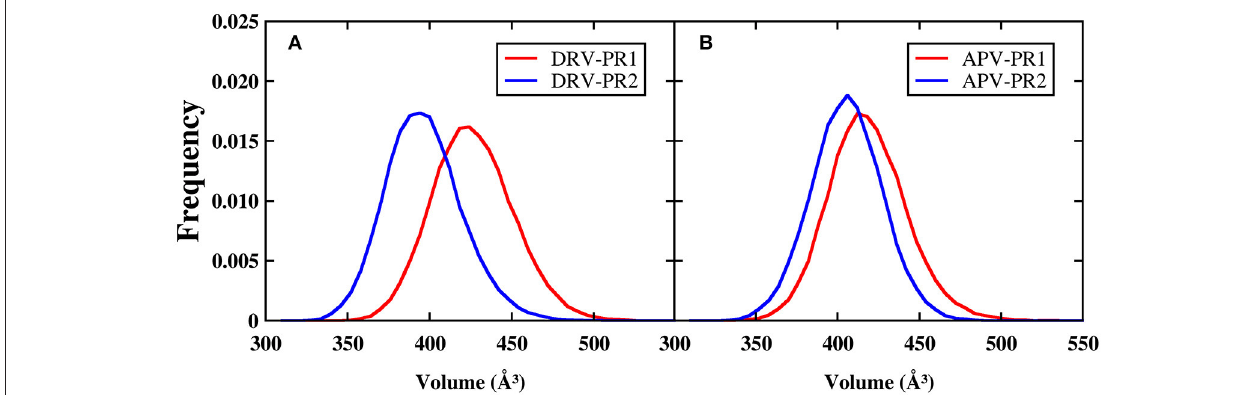
FIGURE 11 | The B-factor of protein C α atoms in the four complexes during MD simulation. (A) DRV complexes. (B) APV complexes.